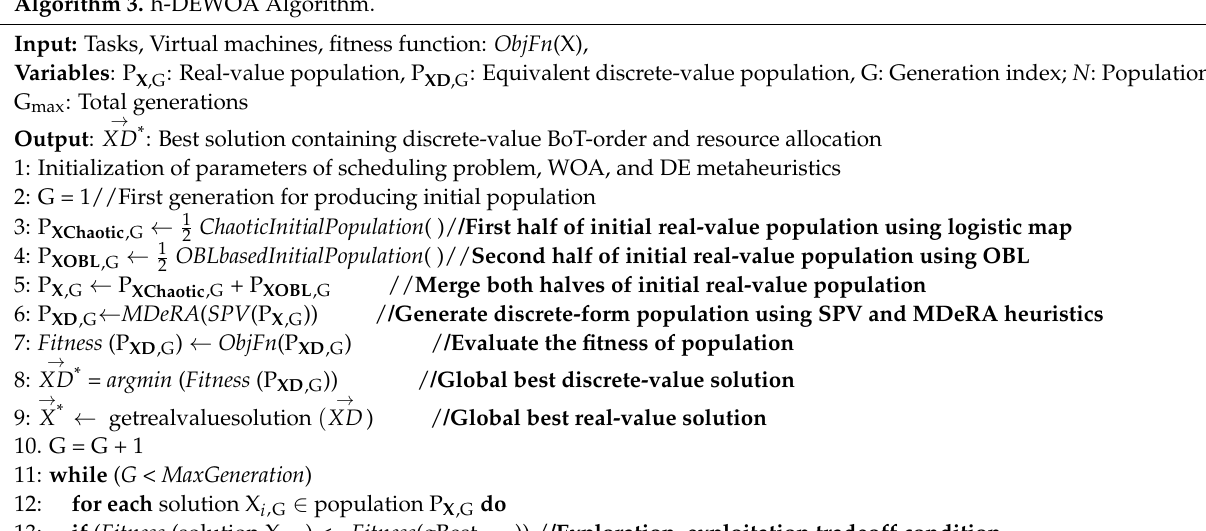
Algorithm 3. h-DEWOA